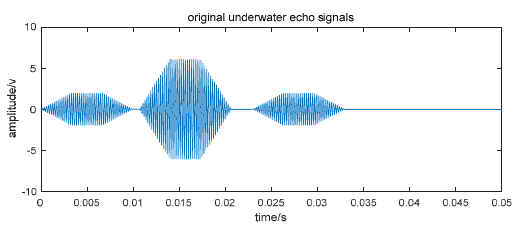
Figure 2. Simulation results of underwater echo signals.